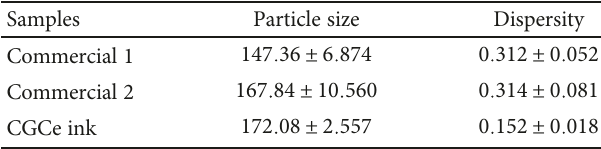
Table 4: Particle size and dispersity of di ff erent